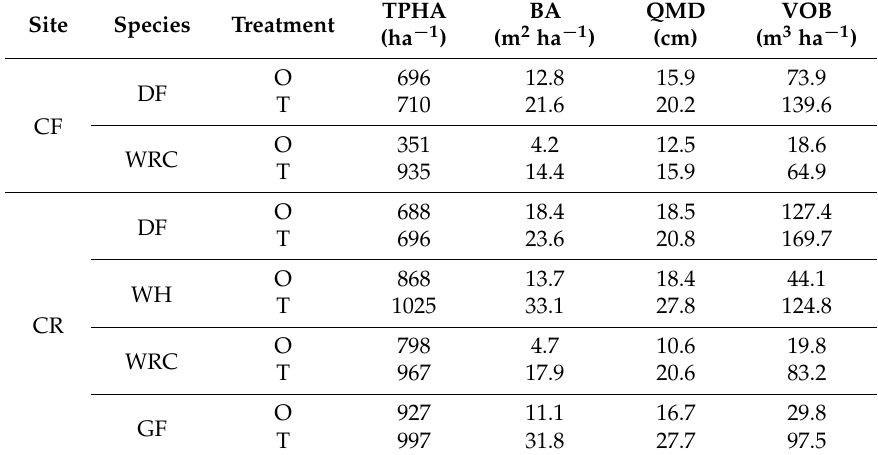
Table 1. Average trees per ha (TPHA, ha − 1 ), basal area (BA, m 2 ha − 1 ), quadratic mean diameter (QMD, cm), and volume outside bark (VOB, m 3 ha − 1 ) for 15–16-year-old Douglas-fir (DF), western hemlock (WH), western redcedar (WRC), and grand fir (GF) trees growing under contrasting vegetation management treatments on sites located in the Cascade foothills (CF; 15 years) and Coast Range (CR:16 years) of western Oregon (Data from Flamenco et al. 2018